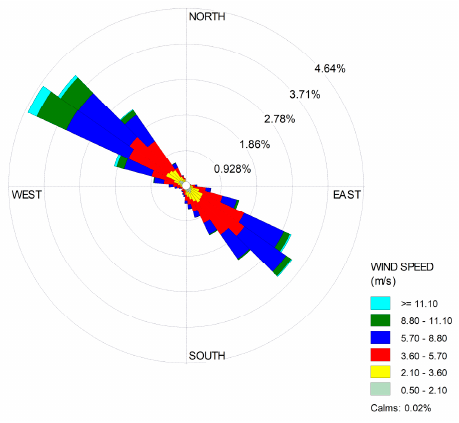
Figure 3. Wind Rose for Bor, period 2011–2015.